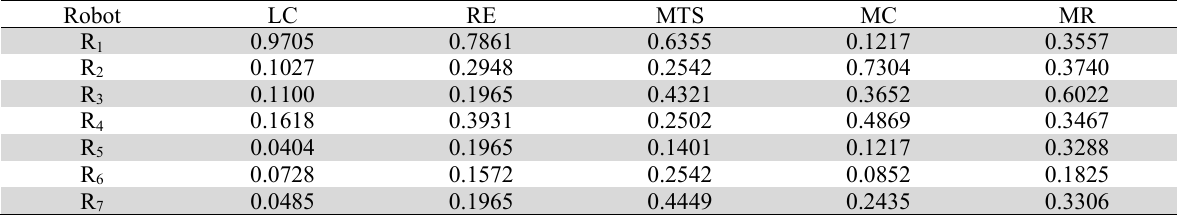
Normalized decision matrix for ratio system of MOORA, reference point and full multiplicative form of MOORA methods